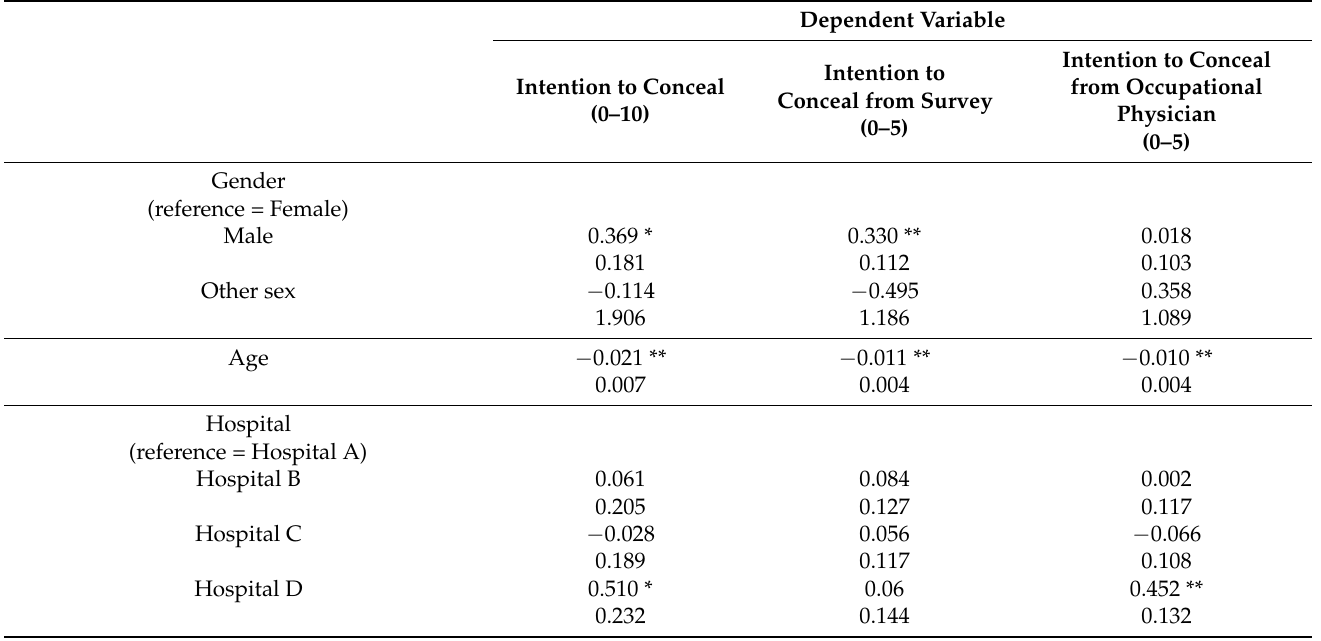
Table 3. Ordinary least squares (OLS) regression results (with standard error) of intention to conceal from survey from occupational physician and intention to conceal in sum (N =